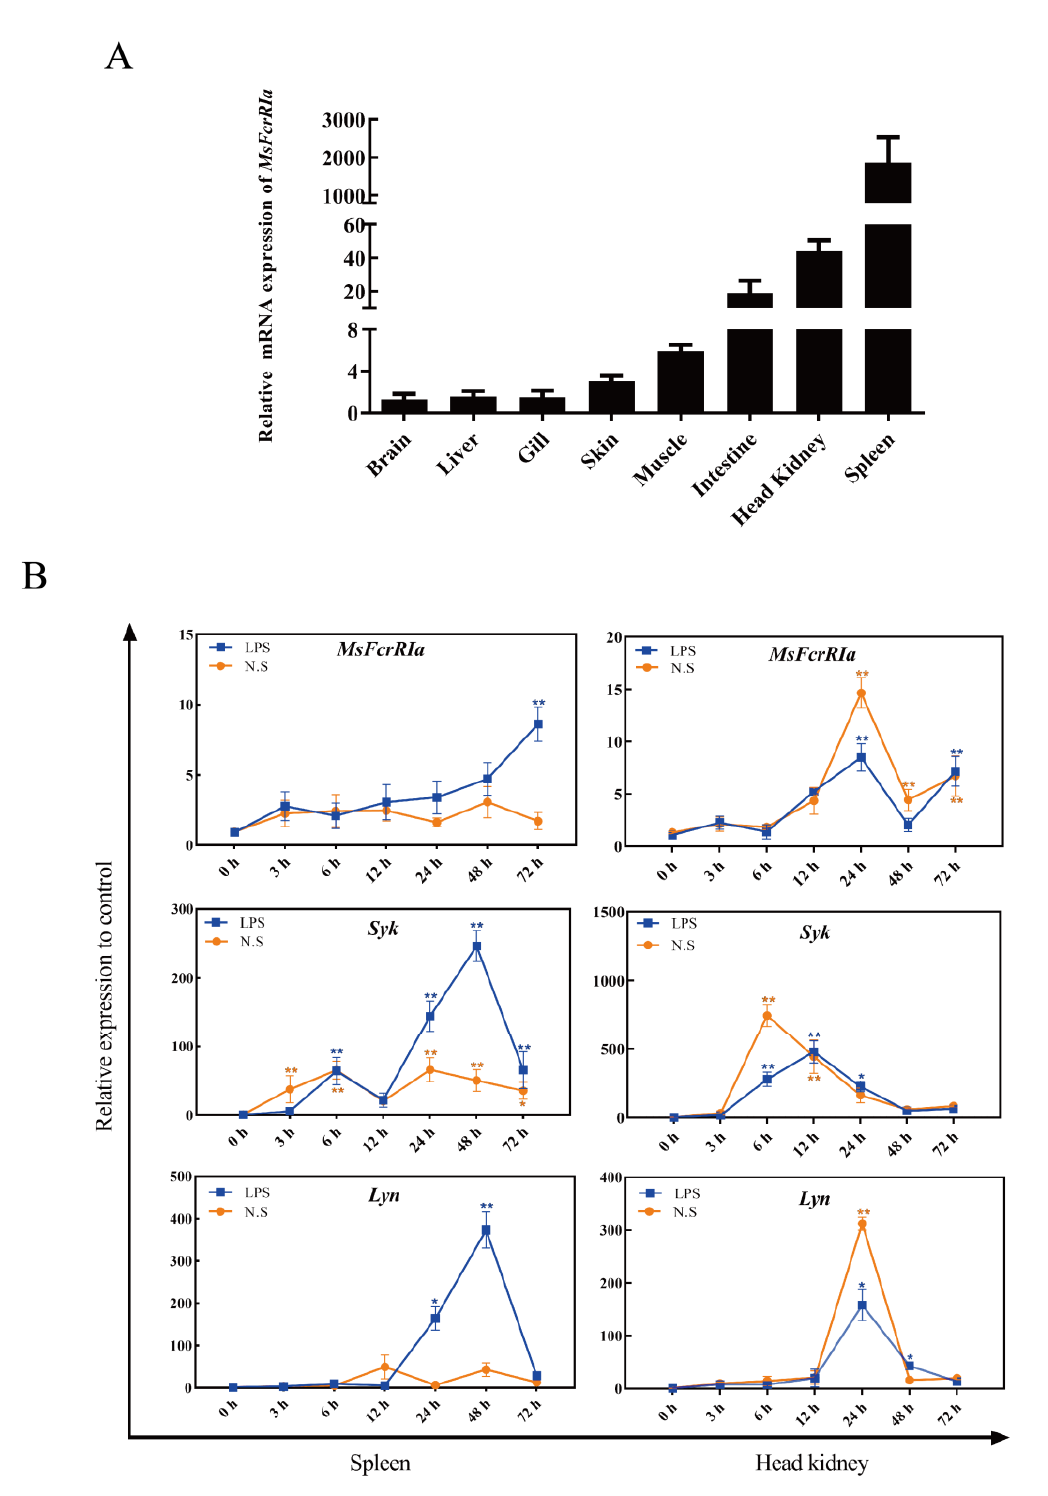
Figure 7. Relative expression analysis of genes in tissues. ( A ) Expression of MsFc γ RI α in healthy largemouth bass tissues. Gene expression levels were normalized by β -actin and compared with the expression level in the brain, n = 3. ( B ) The mRNA level of MsFc γ RI α , Syk , and Lyn after LPS (50 ng/ µ L) or N. seriolae (1 × 10 8 CFU/mL) stimulation in the largemouth bass spleen and head kidney. Gene expression levels were normalized by β -actin. Data are expressed as the mean ± SD compared with the control group (PBS-stimulated), and asterisks show a significant difference ( * p < 0.05, ** p < 0.01). The data were averaged from three independent experiments with three parallel repeats. n = 3.